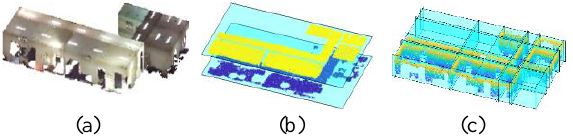
Fig. 1: Extraction of potential permanent structures of a building interior: (a) a point cloud as input data, (b) extraction of horizontal structures from horizontal points, (c) extraction of vertical structures from vertical